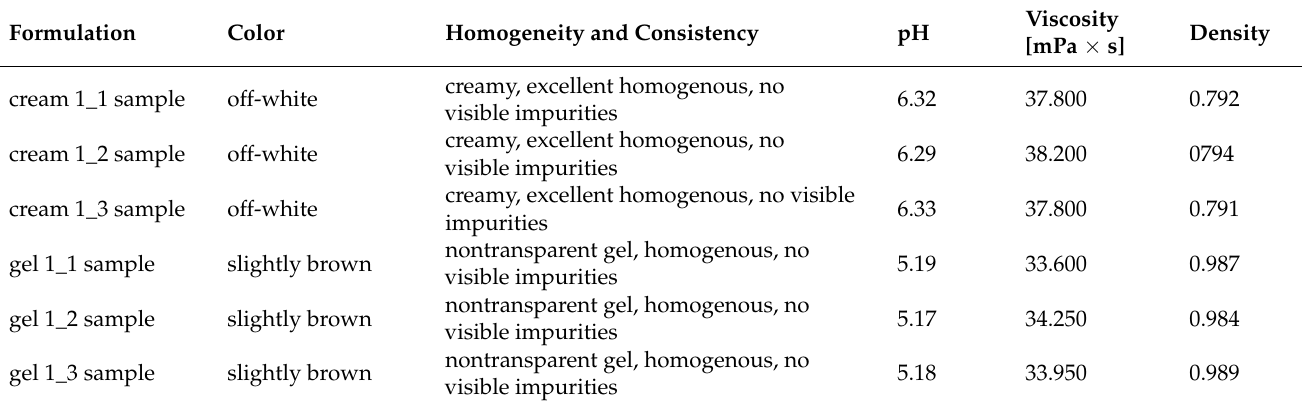
Table 3. Physicochemical properties of all